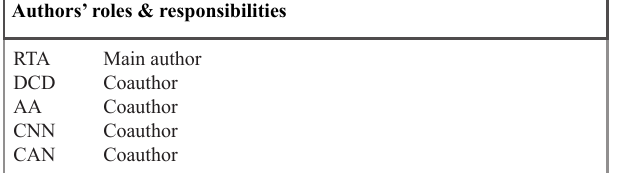
Fig. 4 - Postoperative radiological picture - Chest X-ray